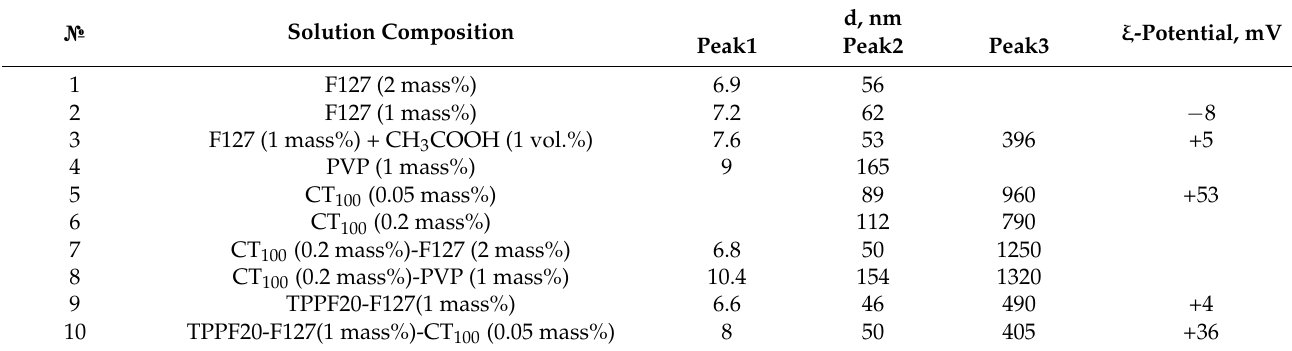
Table 1. Size distribution of associates and ξ -potentials in aqueous and acetic acid solutions of CT 100 , AP, CT 100 -AP, TPPF20-F127, TPPF20-F127-CT 100 .